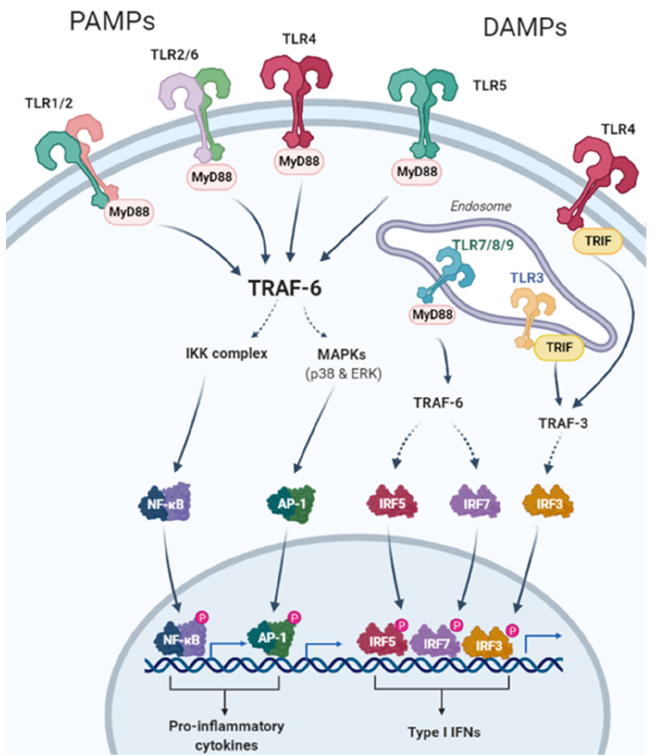
Figure 1. TLR2, TLR1, TLR4, TLR5, and TLR6 are expressed on the outer cell membrane; they recognize both extracellular pathogen-associated molecular patterns (PAMPs) and damage-associated molecular patterns (DAMPs). TLR3, TLR7, TLR8, and TLR9 are located in endosomal compartments where they bind to nucleic acids. All TLRs use the myeloid differentiation primary response protein 88 (MyD88) pathway, except TLR3, whose signaling depends on the IFN- α (TRIF) pathway that contains the TIR domain-containing adapter. TLR activates the MyD88-dependent canonical pathway that, through recruitment of TNF receptor-associated factors (TRAF) 6, leads to the activation of the transcription factor NF-KB, mitogen-activated protein kinase (MAPK), and activator protein-1 (AP-1), with the consequent induction of the production of proinflammatory cytokines. Intracellular TLRs are primarily involved in the type I interferon response. TLR7, TLR8, and TLR9 activate interferon regulatory factor 7 (IRF7) through the recruitment of TRAF6. TLR3 and TLR4 use the TRIF-dependent pathway. TRAF3 is activated and consequently activates IRF3, resulting in the induction of type I interferon (IFN) production. Created with BioRender.com (accessed on 24 February 2022).